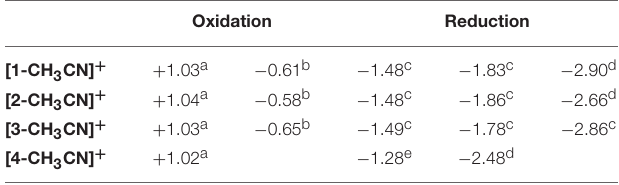
TABLE 1 | Redox potentials recorded by cyclic voltammetry for [1-CH 3 CN] + ,